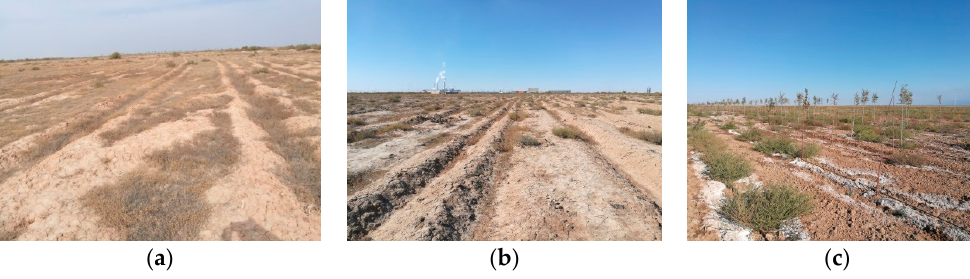
Figure 10. Sampling environment for Area B: ( a ) environment one; ( b ) environment two; and ( c ) environment three.